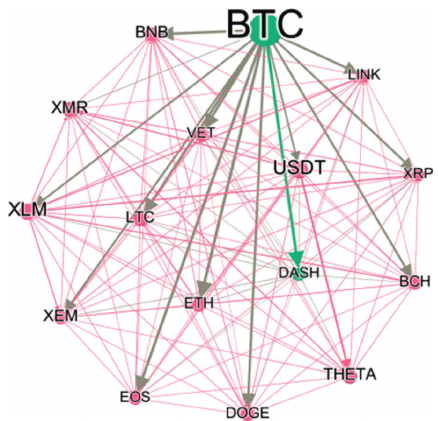
Figure 33: Risk spillover under D8.